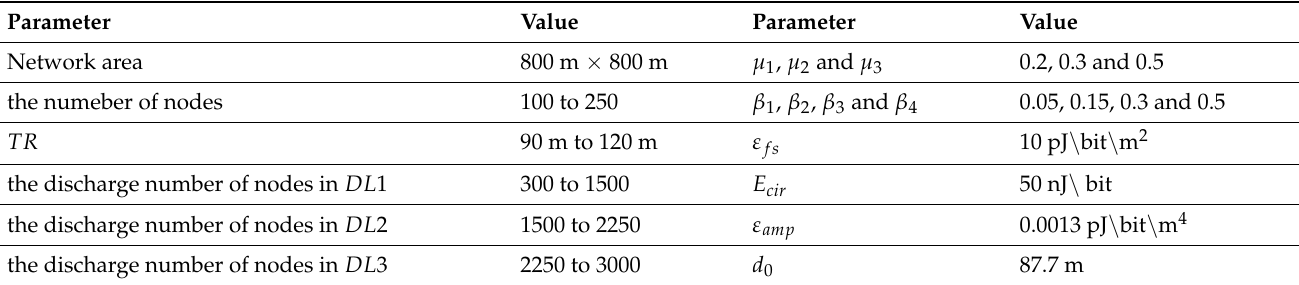
Table 5. The value of important